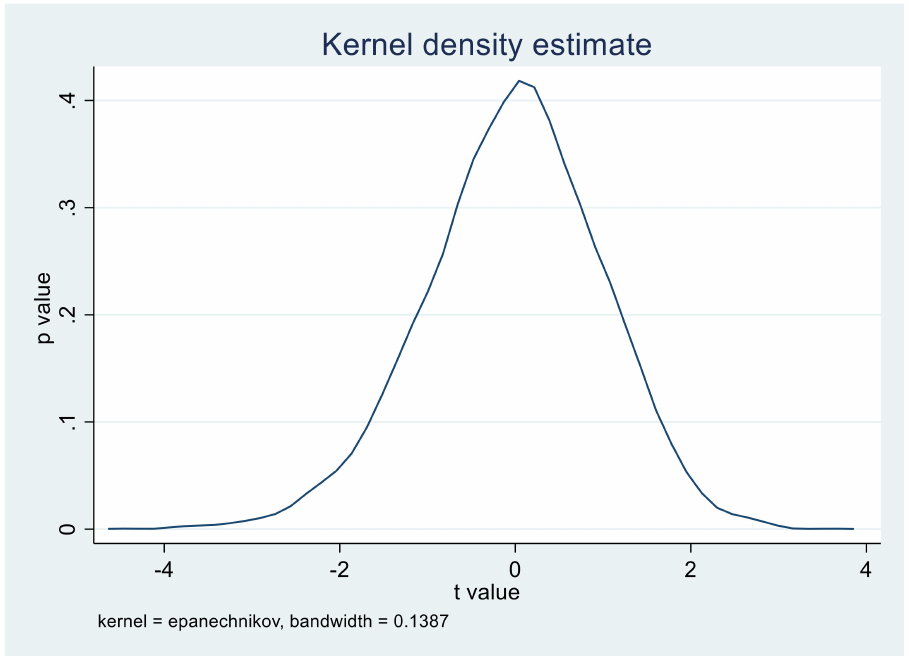
Figure 3. The graph of the policy estimation coefficient of 10,000 random sampling experiment panels with a bandwidth of 0.1387 (fixed-effect